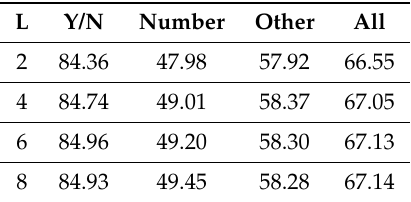
Table 2. Ablation studies of the number of Dense Co-Attention (DCA) layer L on VQA-V2 validation set, where L ∈ { 2,4,6,8 }